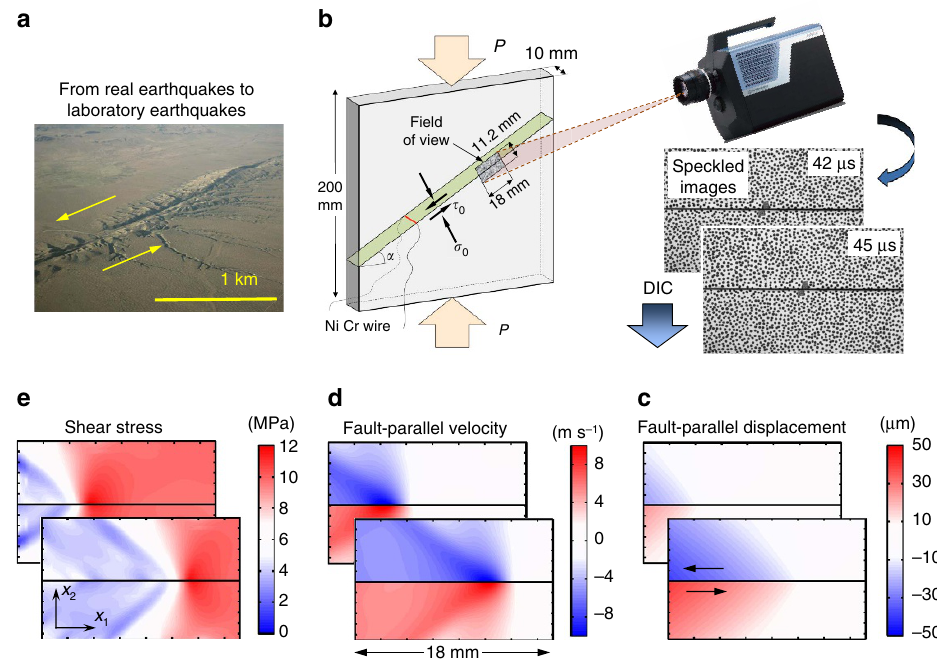
Figure 1 | Imaging mini-earthquake ruptures with our ultrahigh speed full-field technique. ( a , b ) Earthquakes are mimicked in the laboratory by dynamic ruptures propagating along an inclined frictional interface, under the applied shear and normal prestresses simulating tectonic loading applied to a fault within the Earth’s crust. The level of prestress is controlled by the applied far-field loading P and interface inclination angle a . Part of the interface has a speckled pattern applied for the subsequent analysis. The picture of the San Andreas Fault, shown for visual comparison in a , is modified from www.sanandreasfault.org (Copyright ( c ) David K. Lynch). ( c – e ) The full-field time histories of displacements, velocities and stresses are experimentally obtained by capturing sequences of images with ultrahigh speed photography, and processing them with pattern-matching algorithms and highly tailored analysis. The case shown is for P ¼ 23MPa and a ¼ 29 (cid:2) .